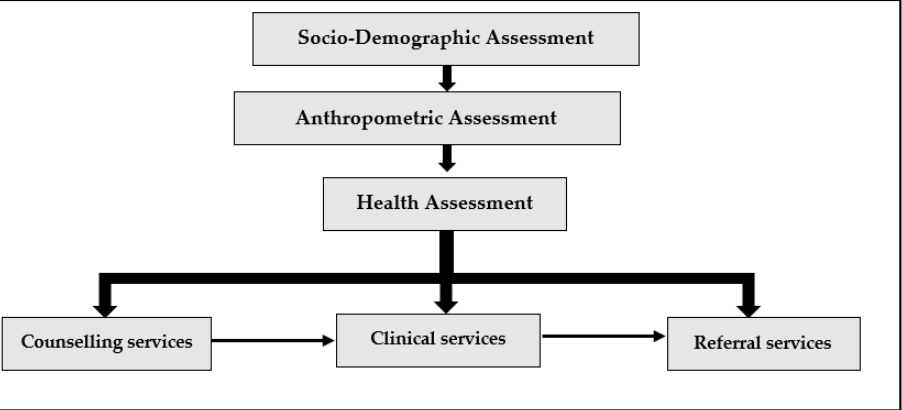
Figure 1. Flowchart for the Beneficiaries in the centre used for assessment by health professionals and doctors.